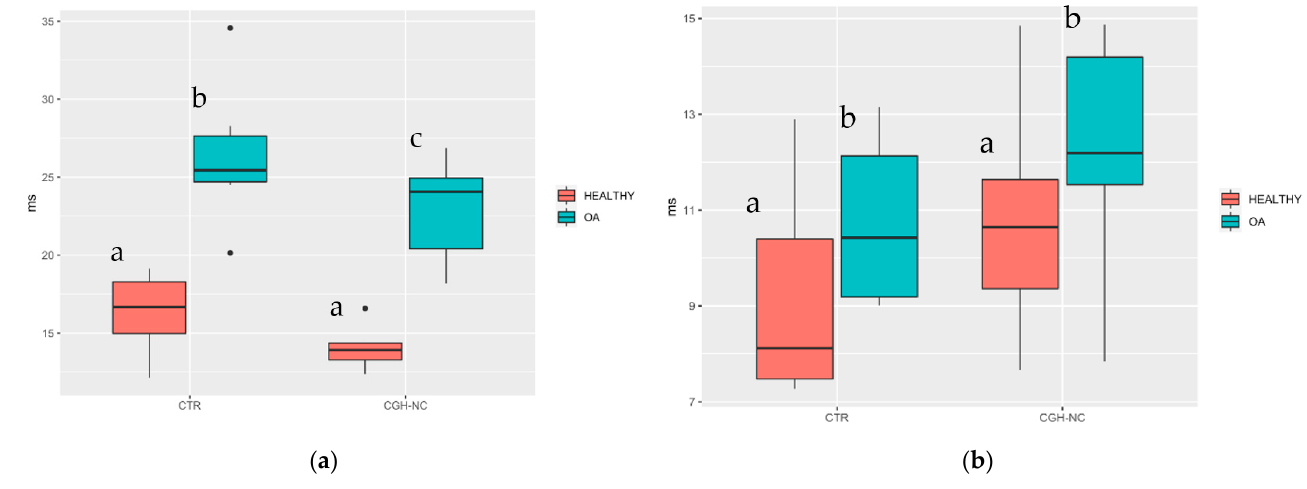
Figure 10. “T2 Femoral PL” ( a ) and “T2 Tibial TM” ( b ) whiskers plots boxes. Healthy stifles showed significant differences compared to OA stifles, regardless of the treatment group. Equally, in the “T2 Femoral PL” variable, differences can be seen in the OA stifles depending on the treatment administration. Different letters indicate statistically significant differences.